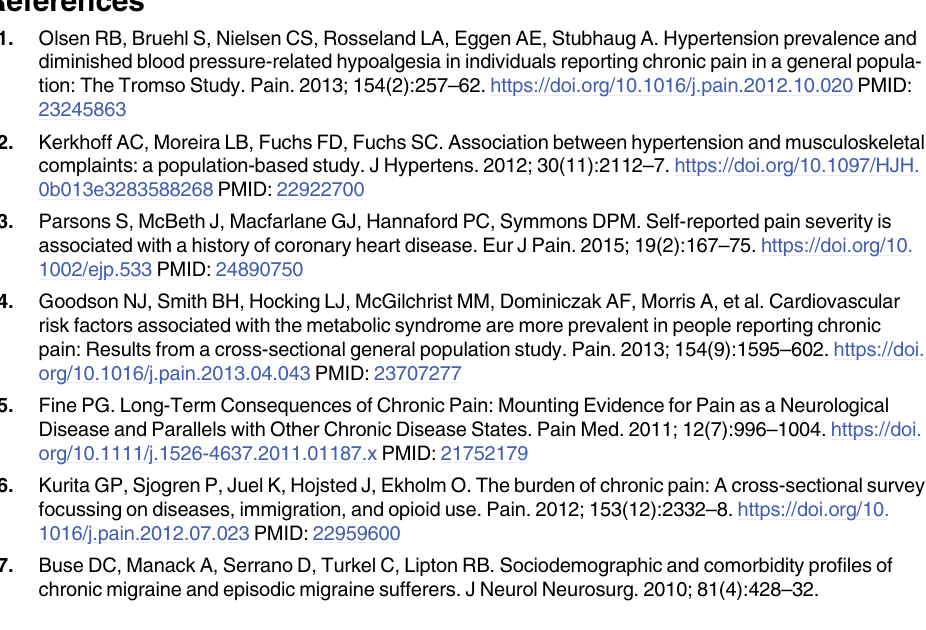
S2 Table. Levels of pain interference in patients with and without hypertension.